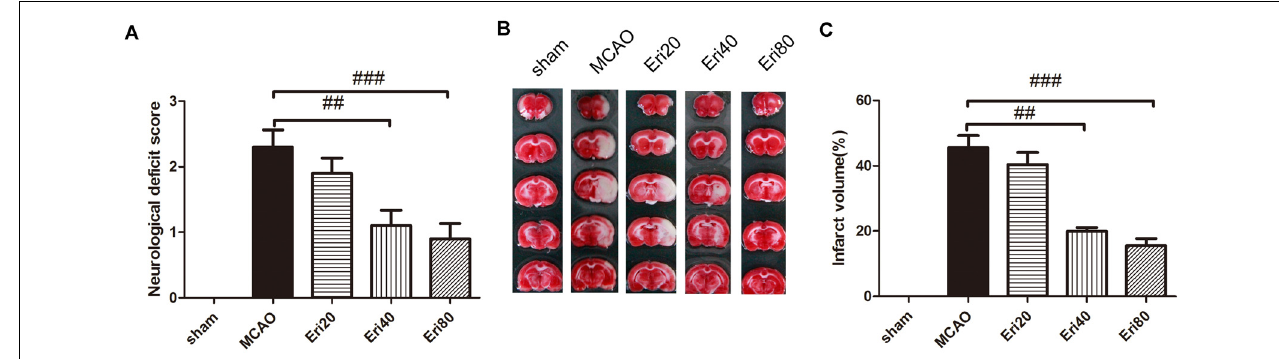
FIGURE 1 | Eriodictyol improved neurological function and reduced middle cerebral artery occlusion (MCAO)-induced brain injury. (A) Rats from different groups received either saline or eriodictyol. The neurological score was calculated 24 h after ischemia. ## P < 0.01, ### P < 0.001, vs. MCAO group, n = 15. (B)